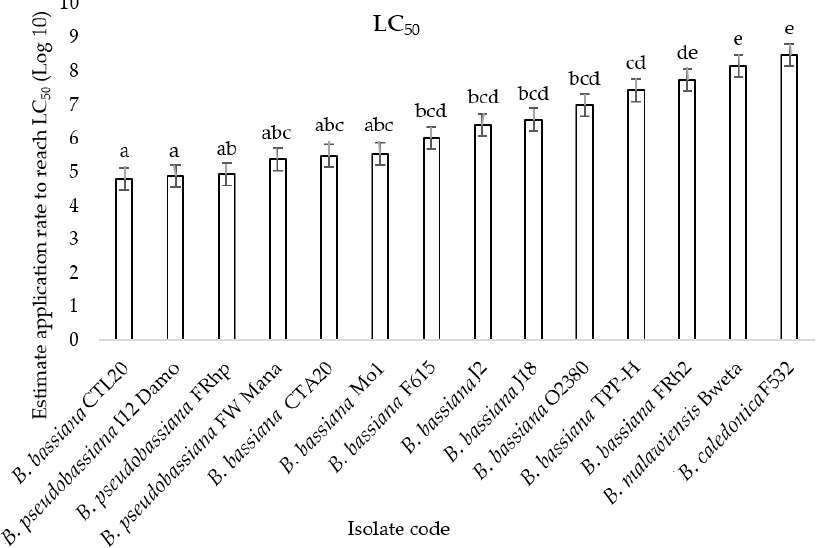
Figure 2. The medium lethal concentration (LC50) values ( ± SE) required to kill diamondback moth larvae for 14 selected isolates of Beauveria . Bars followed by the same letter are not significantly different according to Tukey’s HSD test ( p > 0.05).